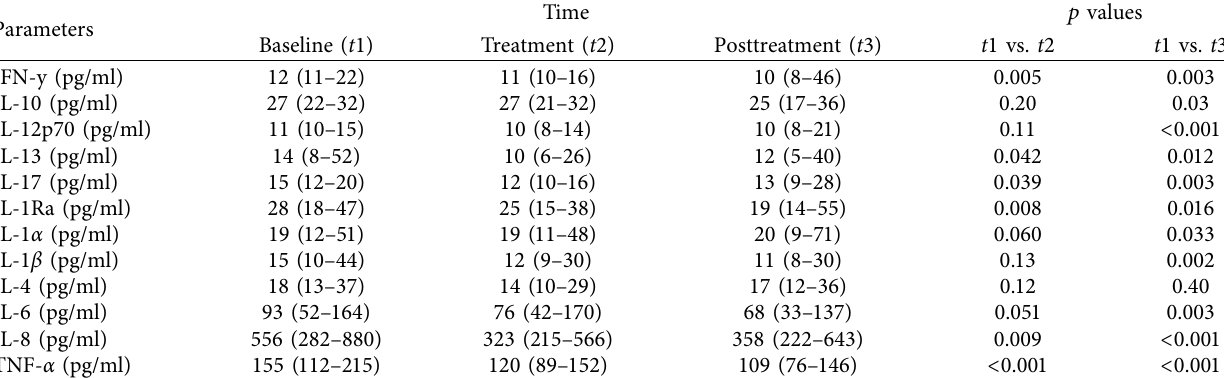
Table 2: Infammatory and immunological parameters.